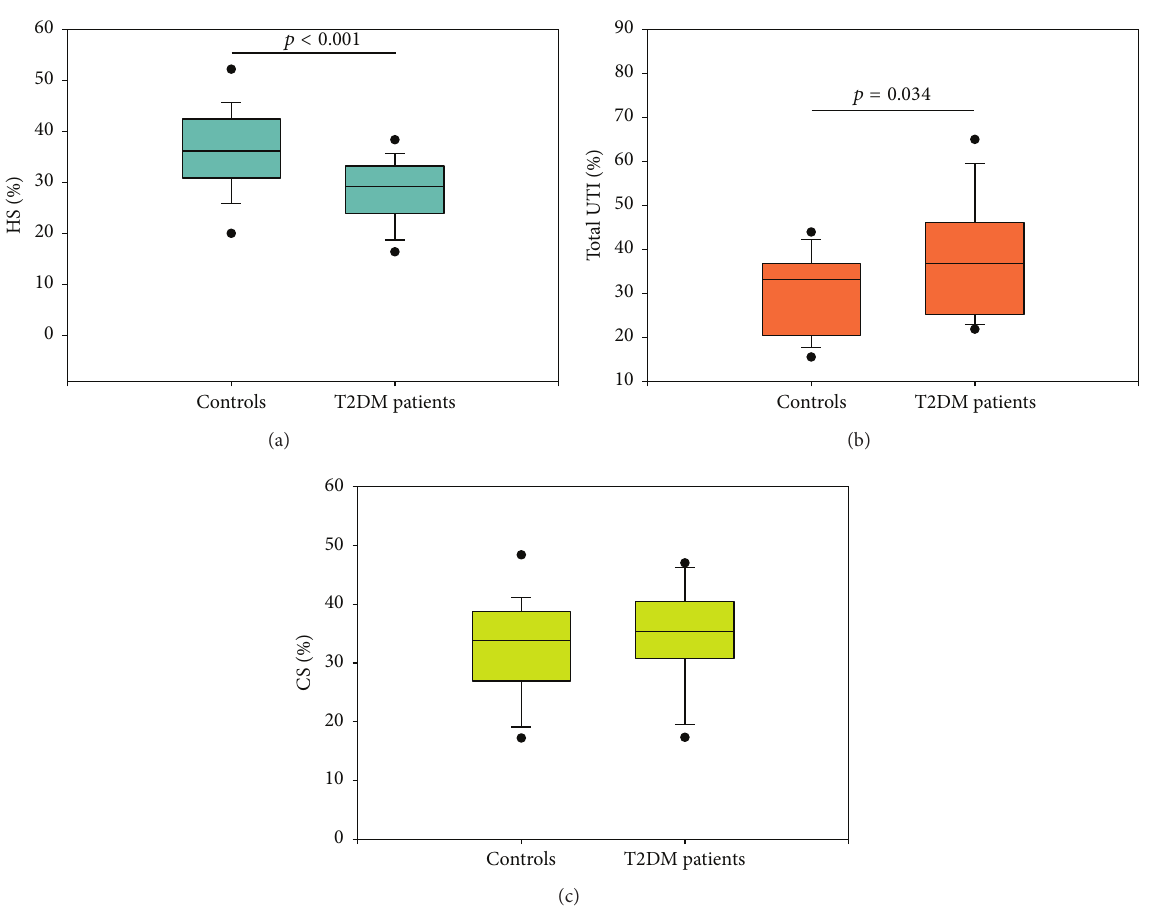
Figure 2: Plots showing the median (line within box), 25th and 75th percentiles (box), 5th and 95th percentiles (whiskers), and outliers ( ∙ ) of HS (a), total UTI (UTI plus SM-LSC and LSC) (b), and CS (c) percentages in the controls group and in T2DM patients. Percentages were evaluated by performing image analysis on cellulose acetate electrophoretic profiles using Quantity One software (Bio-Rad Laboratories). Differences with 𝑝 values < 0.05 were considered statistically significant.